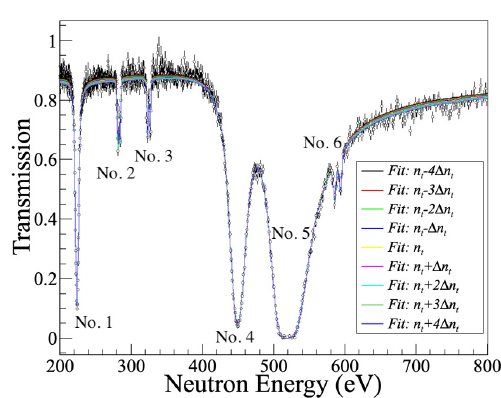
Figure 4. Fitting results for each sample thickness between 200 to 800 eV. The number shows the resonance considered in the present analysis.